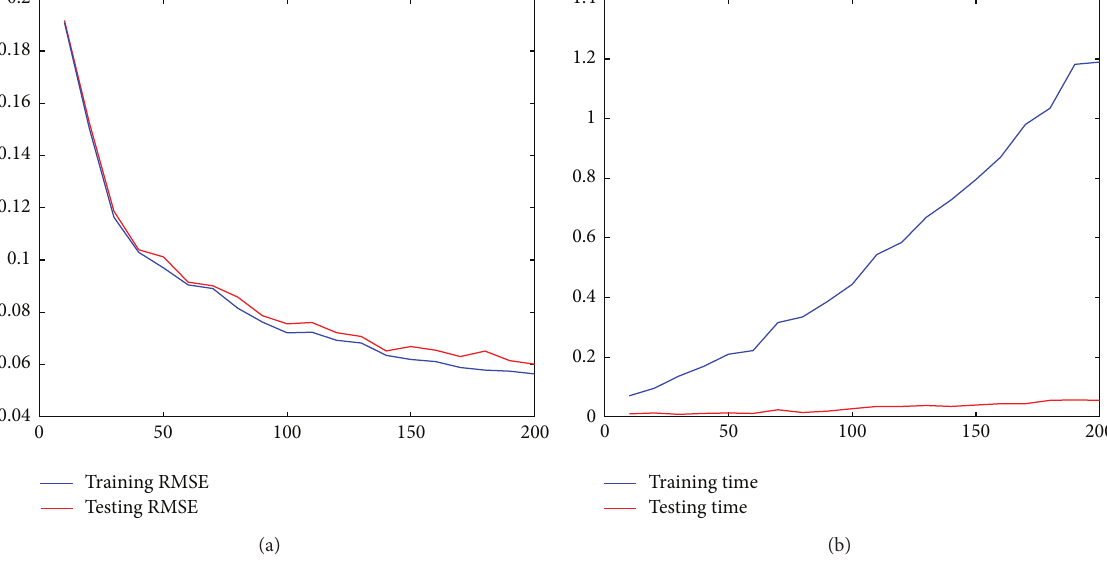
Figure 3: Performance comparison for RVFL net, with respect to hidden nodes. The 𝑥 -axis of these two subimages represents the number of hidden nodes, which varied from 10 to 200 with step size 10. The left subimage is the training and testing RMSE and the right subimage is corresponding training and testing